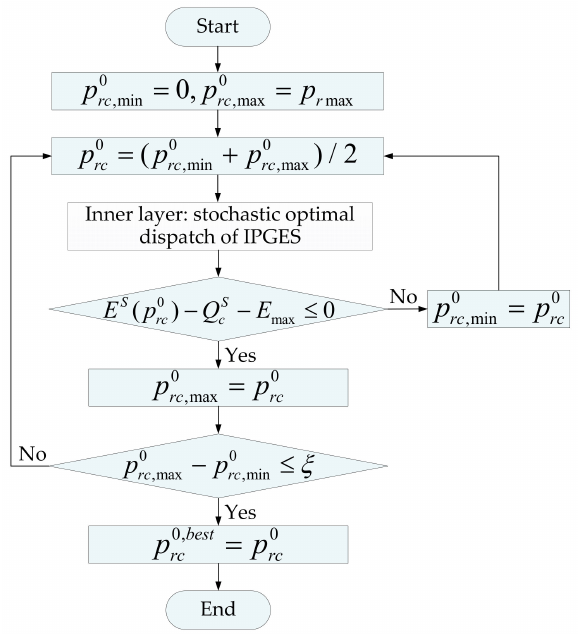
Figure A1. Flow chart for solving outer model.